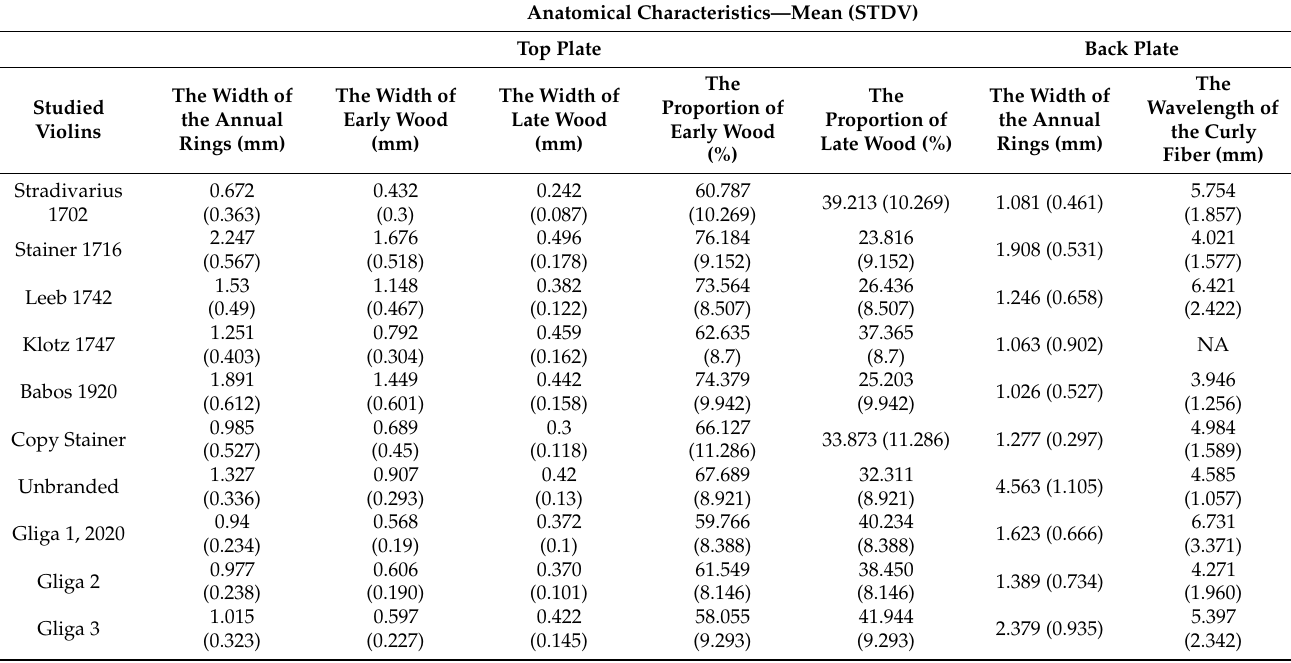
Table 1. Anatomical characteristics of spruce and maple wood on the front and back plates of the studied violins. Anatomical Characteristics—Mean (STDV) Top Plate Back